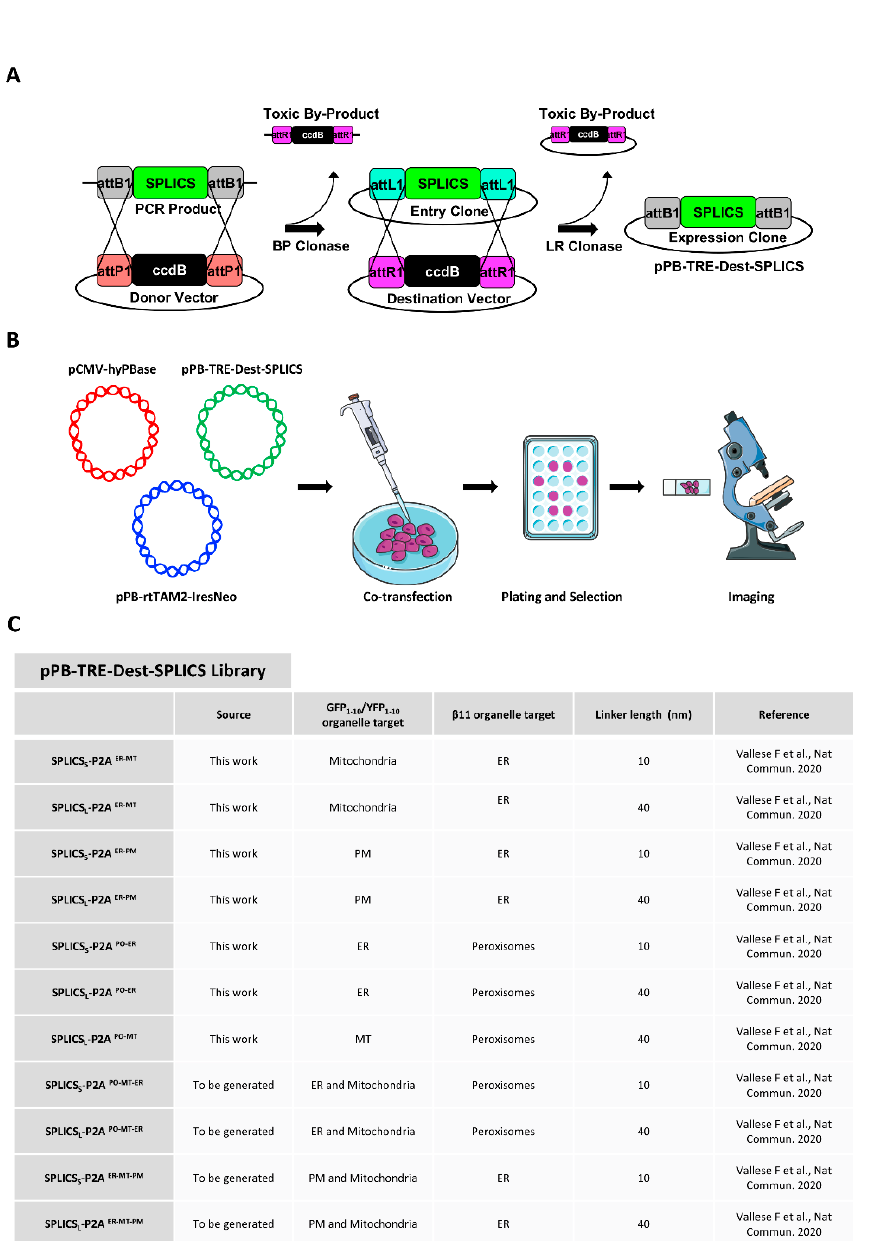
Figure 1. Graphical representation of fundamental steps to generate stable cell lines expressing SPLICS S/L -P2A probes. ( A ) Cartoon representation of Gateway system (Invitrogen) to obtain the pPB-TRE-Dest-SPLICS library. ( B ) Workflow to stably transfect HeLa cells with SPLICS S/L -P2A probes. Three plasmids were used to stably transfect HeLa cells: p-HyPBase encoding the piggyBac (PB) transposase, pPB-rtTAM2-IresNeo containing the PB sequences and encoding the TET-ON repressor and antibiotic-resistance sequence; and the pPB-TRE-Dest-SPLICS containing the PB sequences and encoding the inducible TET-ON system to produce different SPLICS reporters. ( C ) Table summarizing SPLICS information on organelle target GFP portions and linkers.